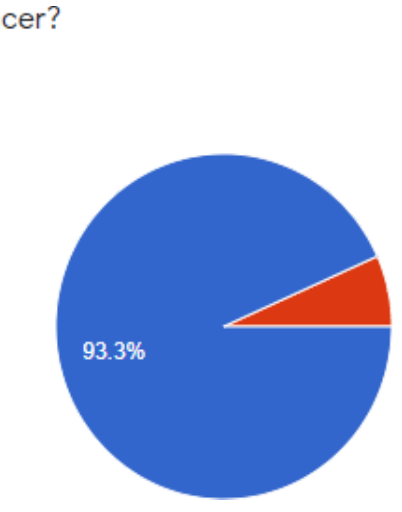
Figure A1. A survey report showing responders profession.